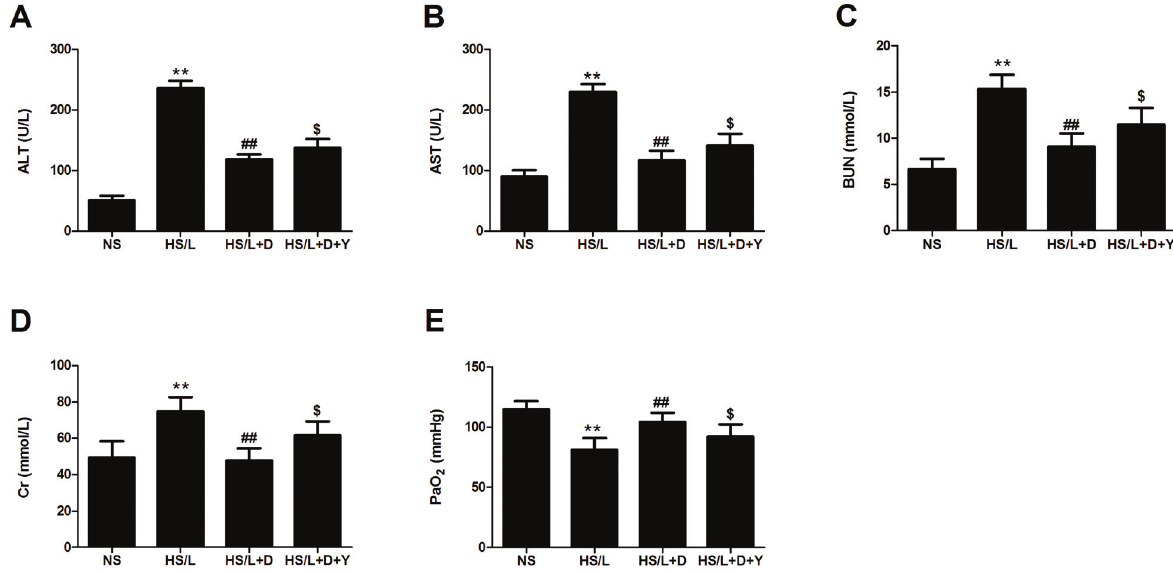
Figure 2. Plasma levels of ( A ) alanine aminotransferase (ALT), ( B ) aspartate aminotransferase (AST), ( C ) blood urine nitrogen (BUN), ( D ) creatinine (Cr), and ( E ) blood gas (PaO 2 ) in the NS control (normal saline), hemorrhage/resuscitation plus lipopolysaccharide (HS/L), HS/L plus dexmedetomidine (HS/L + D), and HS/L + D plus yohimbine (HS/L + D + Y) groups. Data are reported as means ± SD. **P o 0.01 vs the NS group; ## P o 0.01 vs the HS/L group; $ P o 0.05 vs the HS/L + D group (ANOVA).